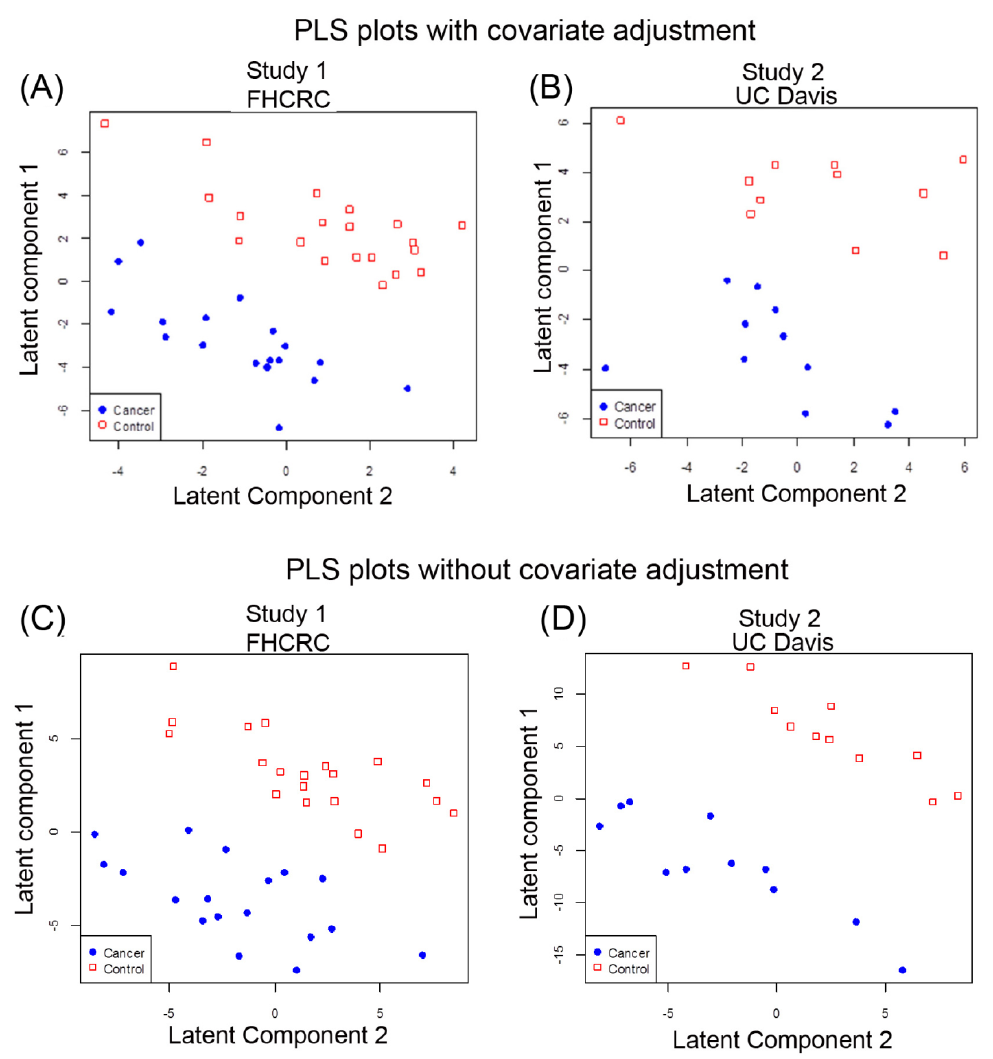
Figure 2. Multivariate PLS separates lung cancer patients and controls in two independent studies by the global metabolomic profiles. ( A ) PLS of Study 1 data results with gender and age adjusted; ( B ) PLS of Study 1 without gender and age adjusted; ( C ) PLS of Study 2 with gender and age adjusted; ( D ) PLS of Study 2 without gender and age adjusted. Red squares denote control cases and solid blue circles denote cancer